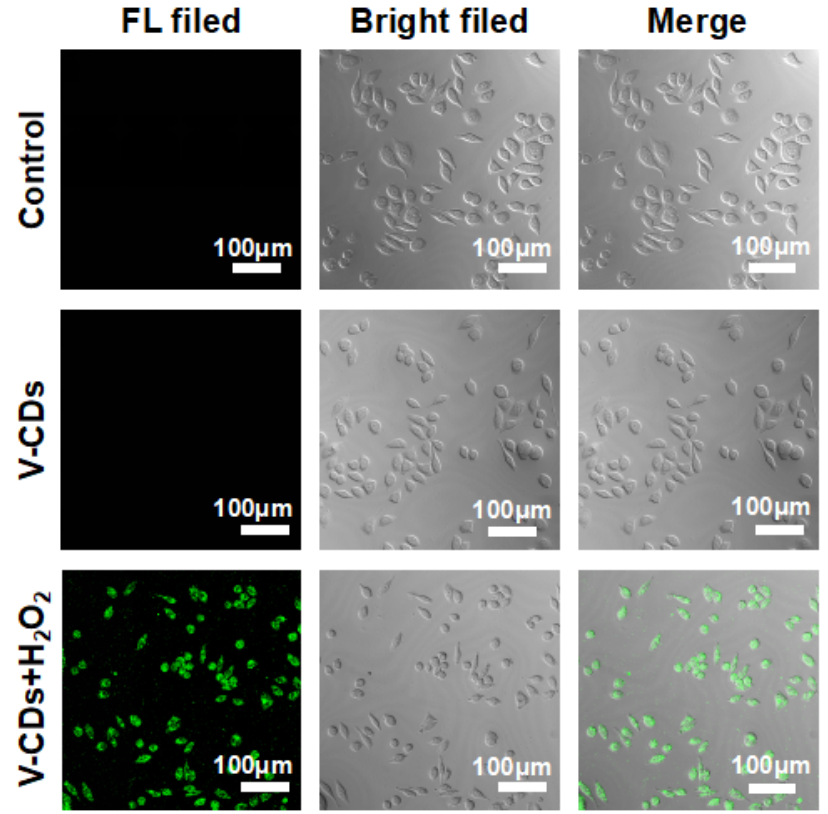
Figure 4. Confocal laser scanning microscope fluorescence images of V − CDs − treated HeLa cells with or without H 2 O 2 . The images of bright field, and the overlay for the corresponding samples were recorded. Scale bar represents 100 μ m.